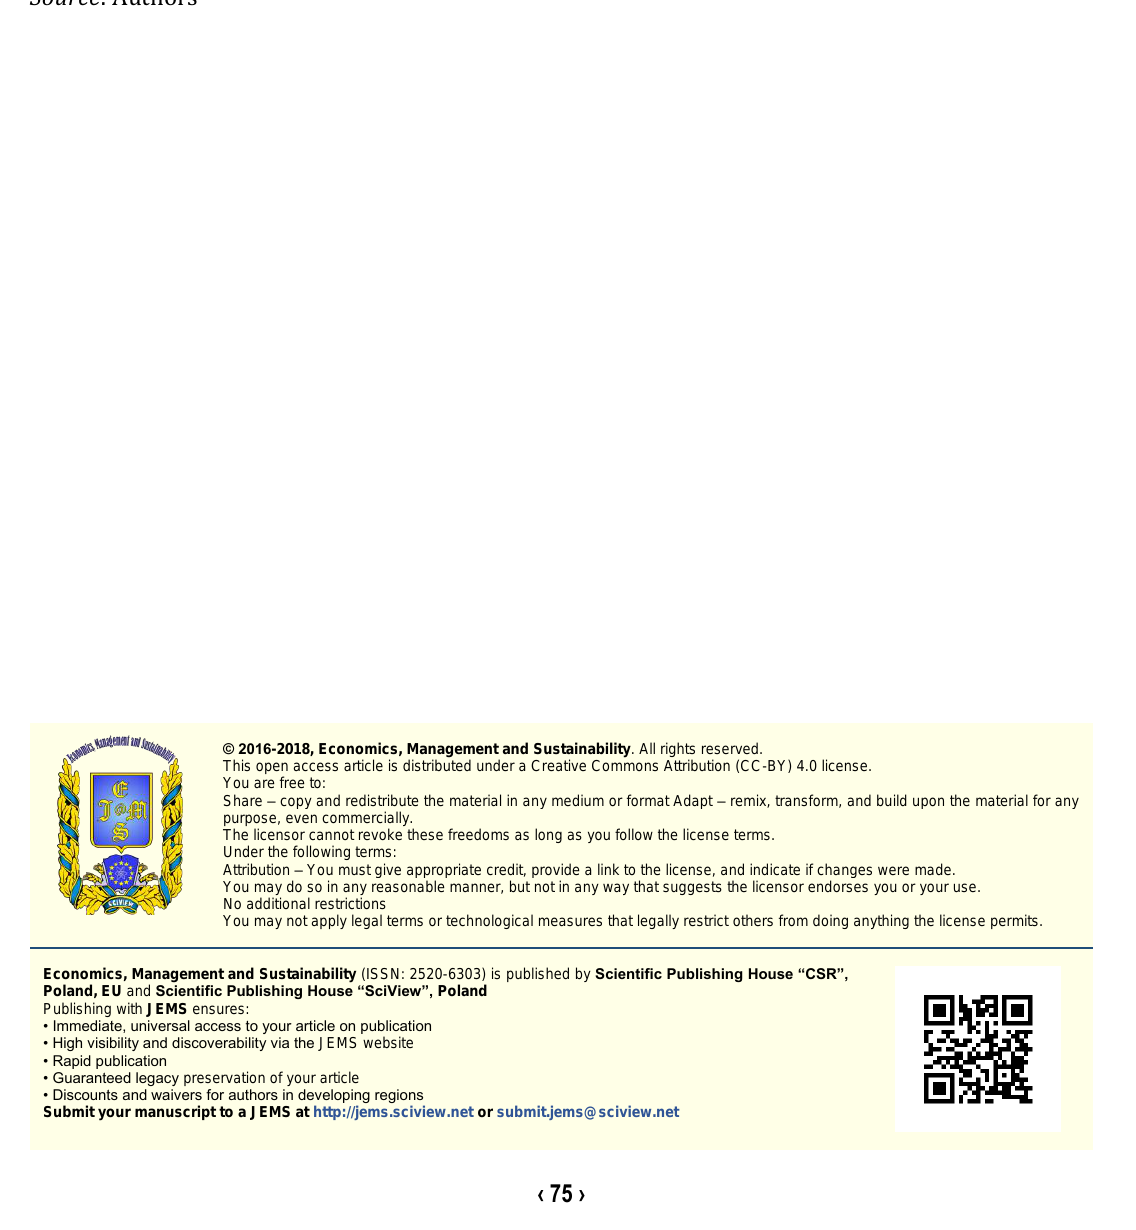
Single member limited liability cy